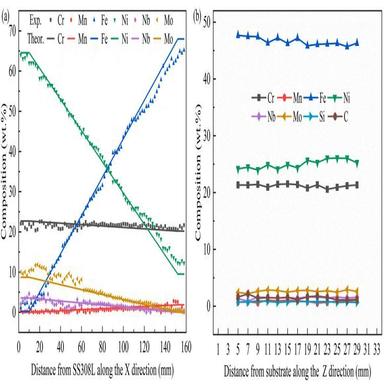
Element distributions (wt%) along the torch-travelling direction (a) and along the building direction (b) of FGM wall. In, the scattered points are measurements, and the lines are theoretical design values.